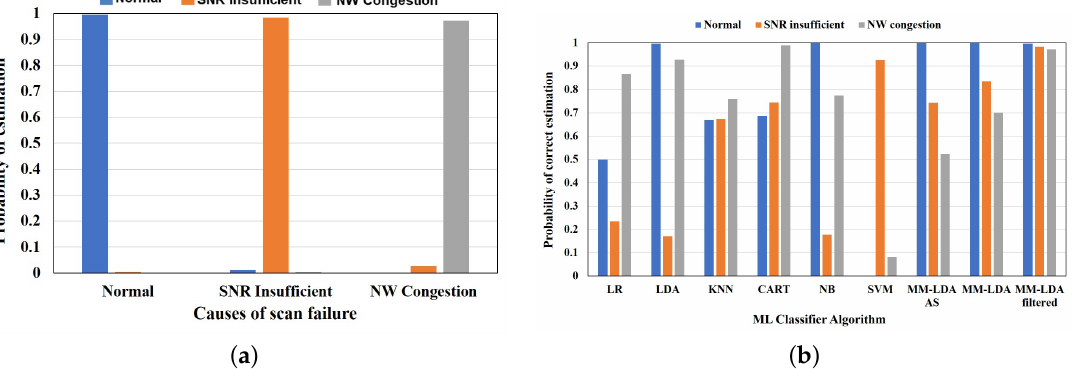
Figure 11. Scan failure/delay cause estimation of the newly acquired scan response samples (set 2). ( a ) Estimation with scan response maximum RTT; ( b ) comparison—proposed method vs. conven- tional